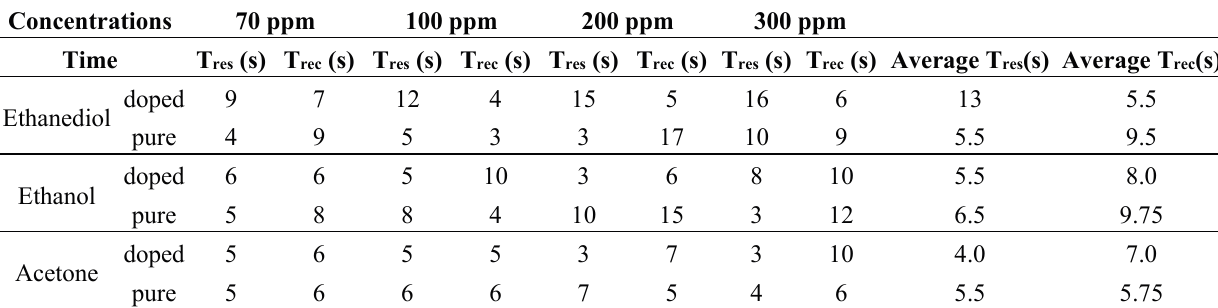
Table 1. The performance of two NB sensors towards different concentrations of VOC gases.